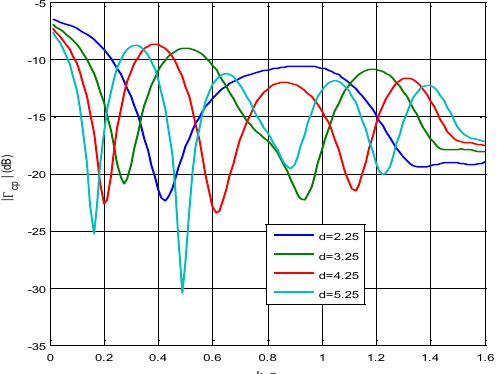
Fig. 6. Variations of the magnitudes of co-polar reflection coefficients versus k Fig. 4. Variations of the magnitudes of reflection circular cylinders of radius a , with coefficients versus k a for buried PEMC circular 0 45 o , and for different values of the burial depth d cylinders of radius a , with  = 2.0, d = 5.0 cm, r for different values of ν ; (a) co-polar coefficient; (b) cross polar coefficient.